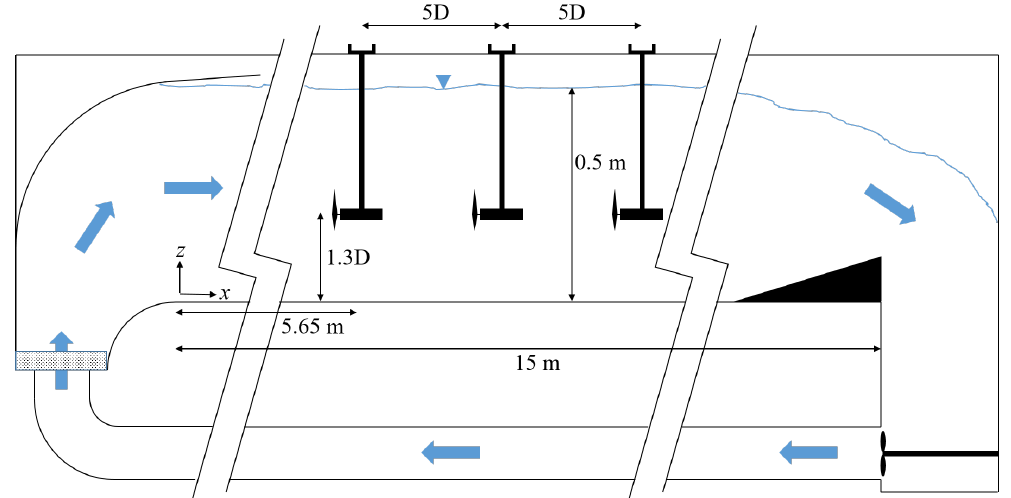
Figure 1. Elevation view of the 2 m wide flume in which the experiments are performed. The flow travels from the pumps through two parallel pipes, through a honeycomb mesh at the base of the inlet tank, is turned into the test section, and finally passes over a weir into the outlet